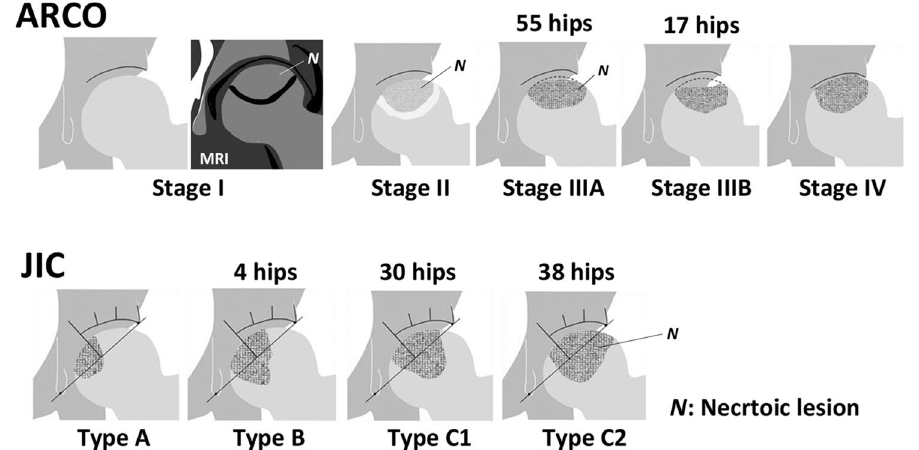
Figure 1. Diagrams showing the 2019 revised Association Research Circulation Osseous (ARCO) and the Japanese Investigation Committee (JIC) systems. ARCO Stage I, T1 low-intensity band on MR imaging without any specific findings on plain radiographs; Stage II, demarcating sclerosis without collapse on plain radiographs; Stage IIIA, lesser than or equal to 2 mm collapse; stage IIIB, greater than 2 mm collapse; Stage IV, osteoarthritic changes. In this study, 55 hips are classified as stage IIIA and 17 hips as stage IIIB. JIC Type A, necrotic area occupies the medial one-third or less of the weight-bearing portion; Type B, medial two-thirds or less; Type C1, more than two-thirds but not extending to the acetabular rim; Type C2, more than two-thirds and extending to the acetabular rim. In this study, 55 hips are classified as stage IIIA and 17 hips as stage IIIB, and 4 hips are type B, 30 hips are type C1 and 38 hips are type